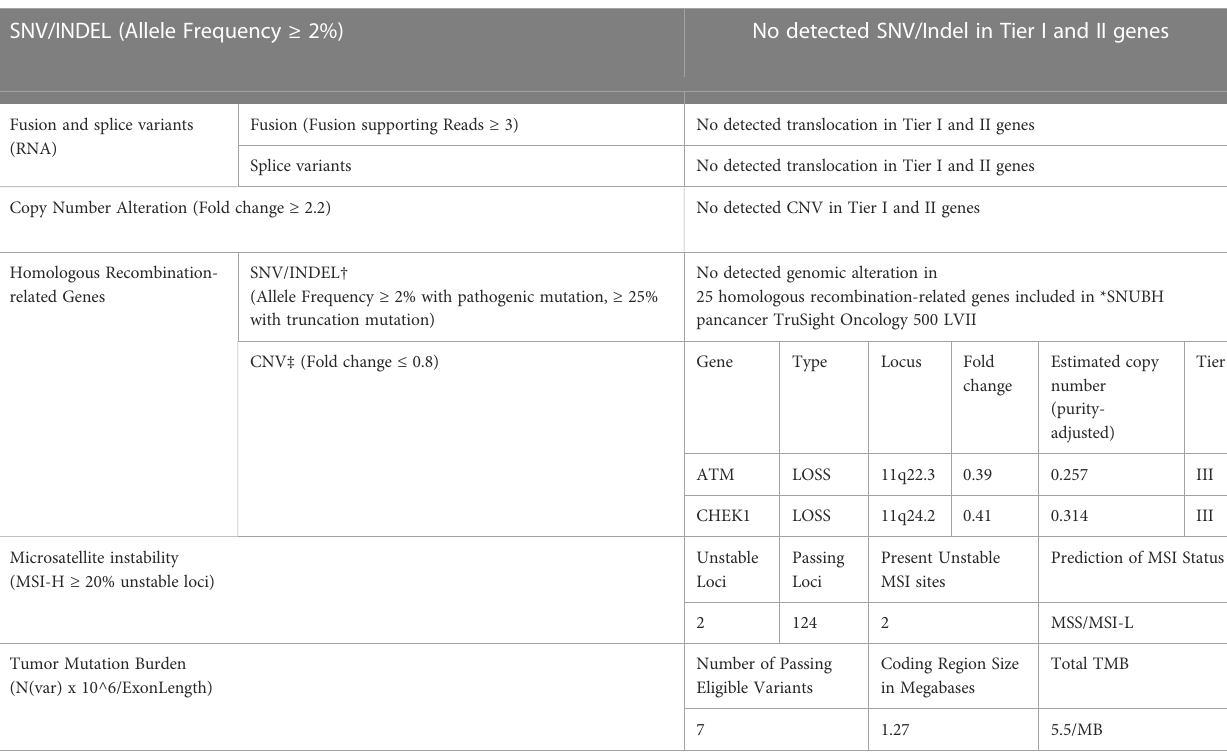
Fusion and splice variants